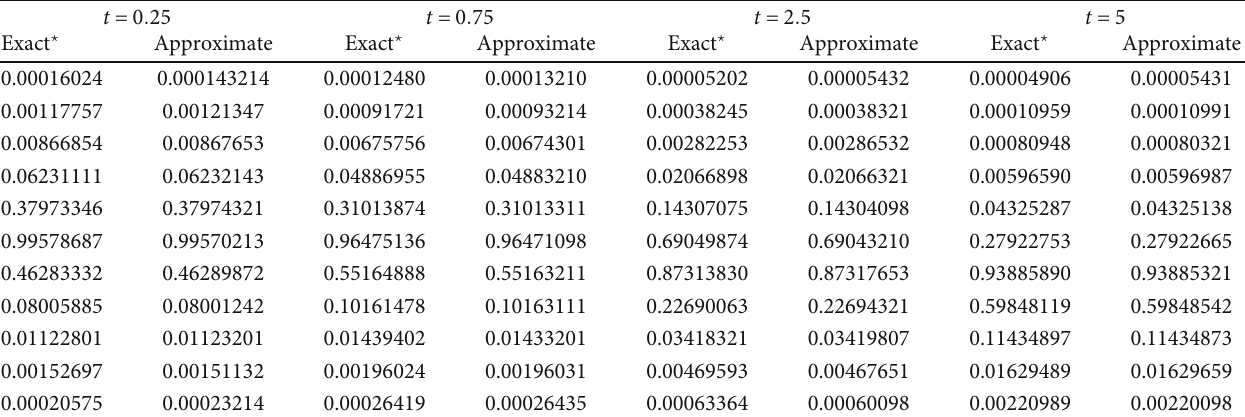
Table 1: Exact and approximate results for various time levels with α = 0 : 95